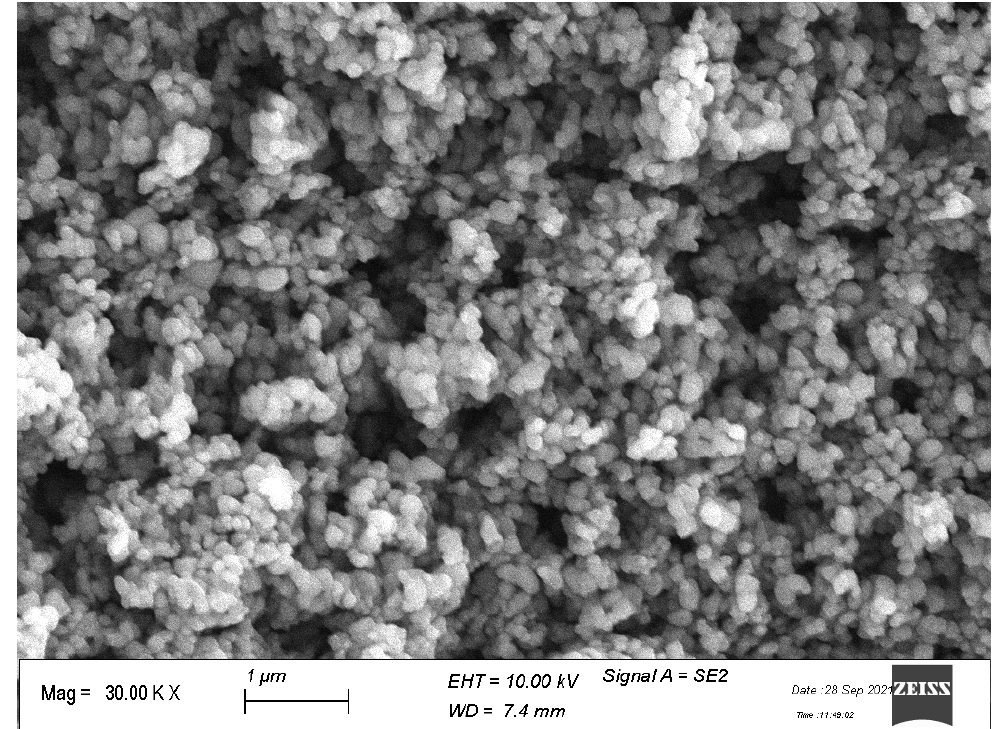
Figure 3. SEM image of a sample of TiO 2 and PVA deposition over vetronite at 30,000 ×